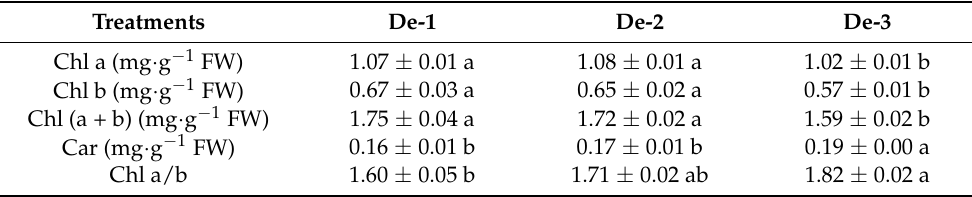
Table 1. Pigment contents of kale grown under different depths of nutrient solution.